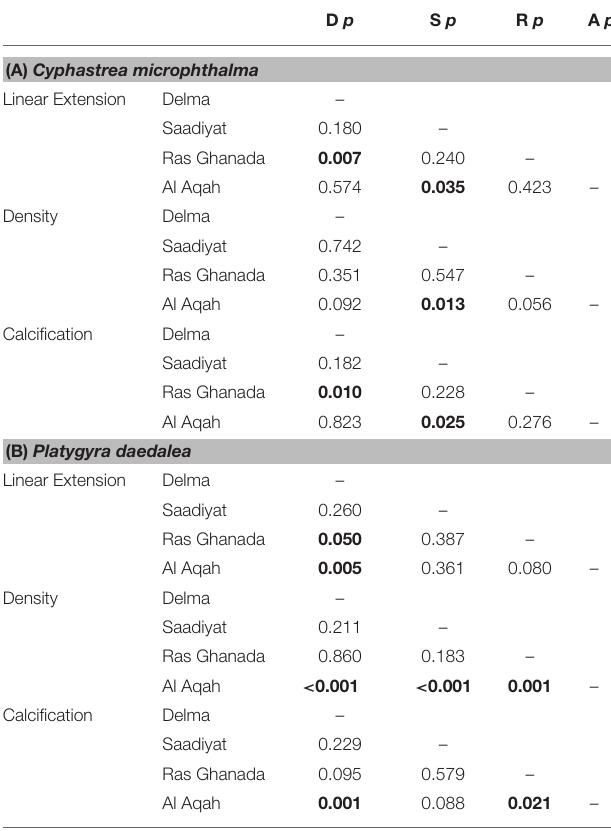
TABLE 2 | Summary of site contrasts in linear extension, density, and calcification Generalized Linear Mixed Models for (A) Cyphastrea microphthalma and (B) Platygyra daedalea in the Persian Gulf and Oman Sea.